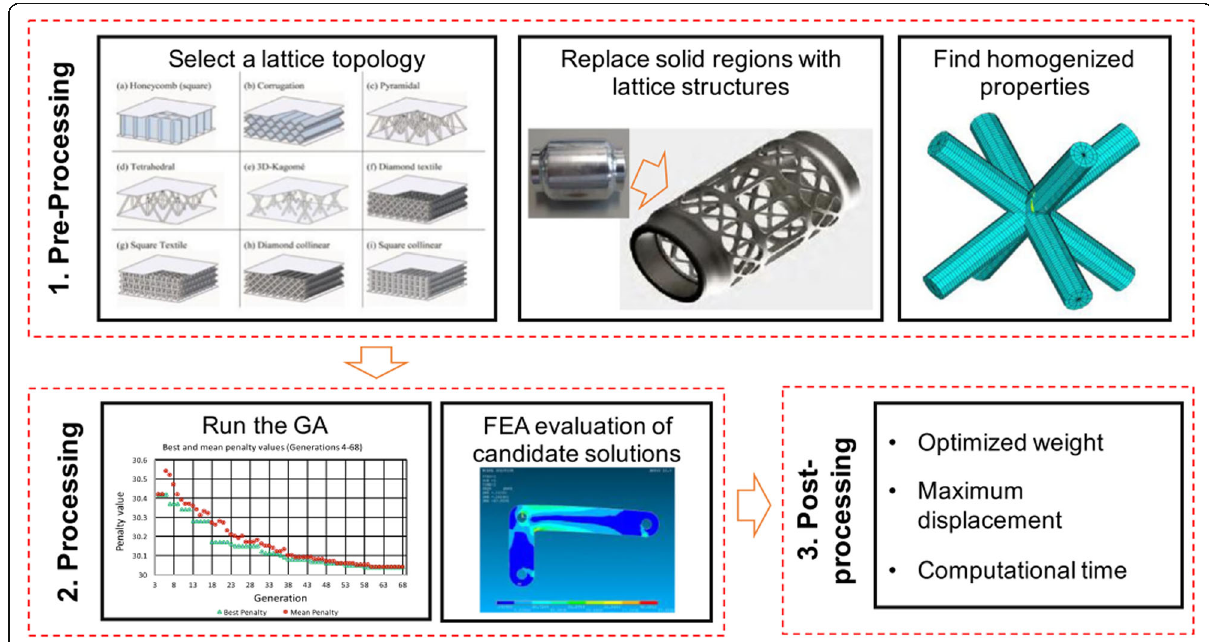
Fig. 24 Workflow of the design and analysis of lattice structures